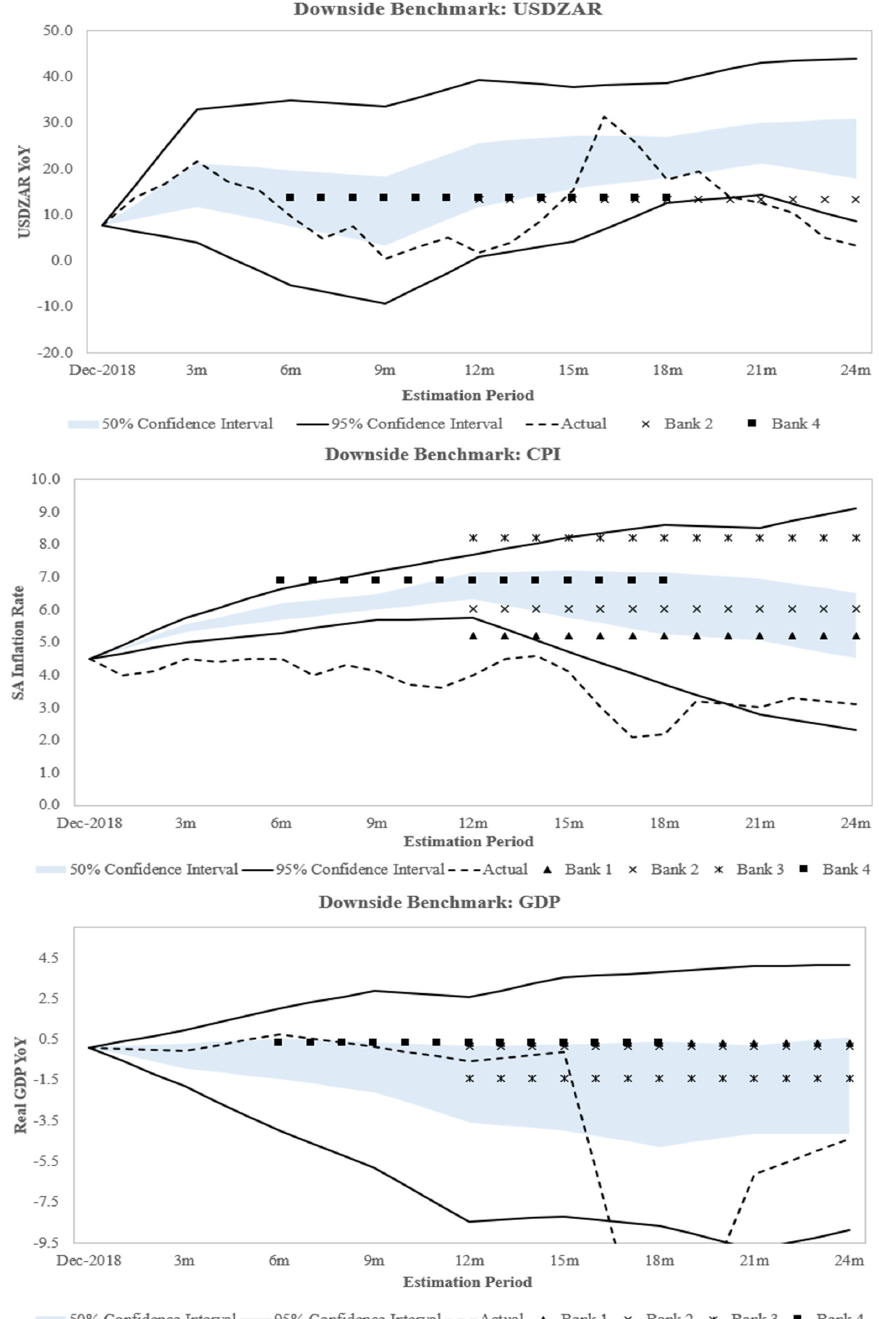
Figure 8. Illustrating the benchmark approach for the downside scenarios as published in the annual financial statements of the South African banks for FYE 2019.